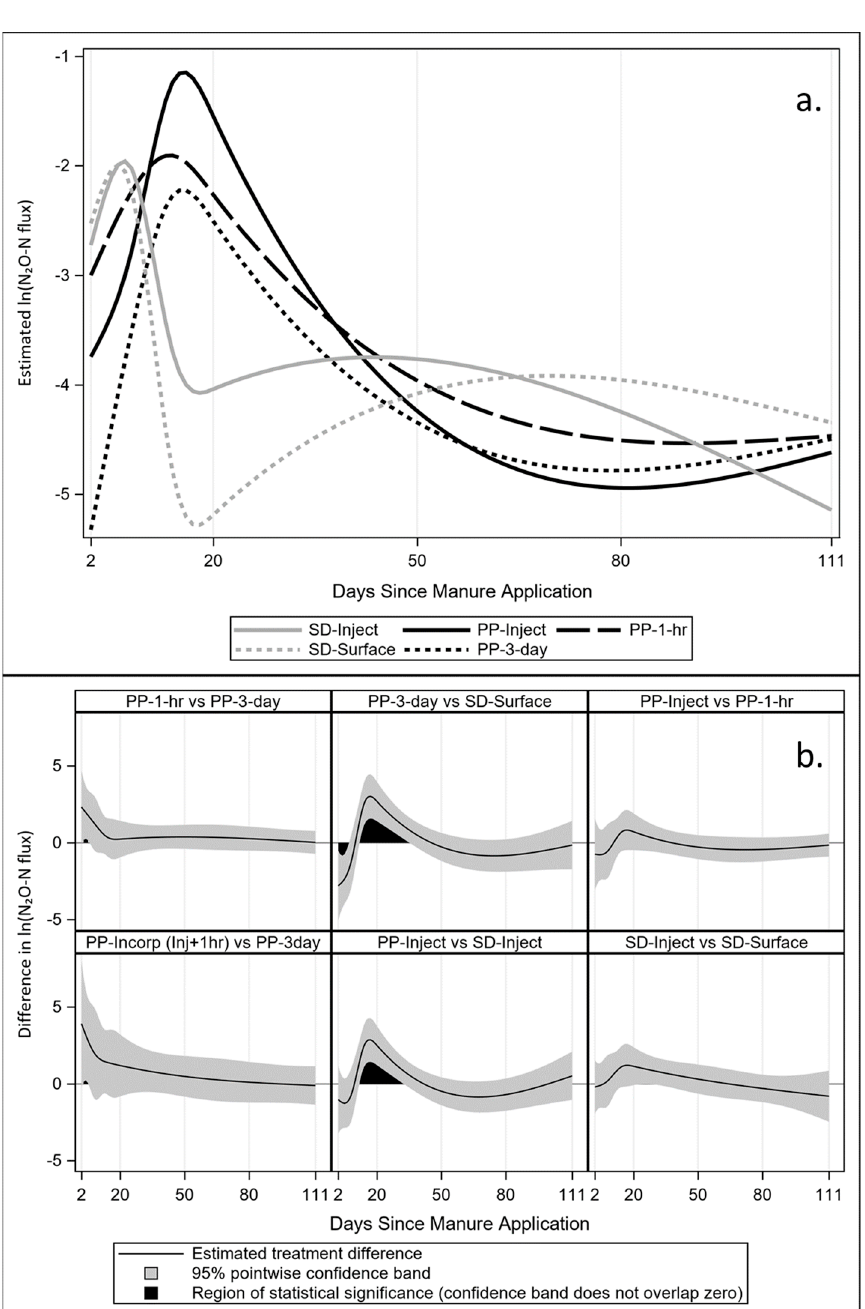
Figure 4. Nitrous oxide (N 2 O) emissions predicted by the linear mixed model developed as a function of the number of days after manure application ( a ). Differences in N 2 O emissions between application methods in the days following manure application. The region of statistical significance for days since manure application (positive (negative) indicates that the estimate for the first treatment listed in the comparison was higher (lower) than the second treatment listed): PP-1-hr vs. PP-3-day, days 3–5 (positive); PP-3-day vs. SD-Surface, days 2–7 (negative) and days 12–35 (positive); PP-Incorp (Inject + 1-hr) vs. PP-3-day, days 3–5 (positive); PP-Inject vs. SD-Inject, days 12–32 (positive) ( b